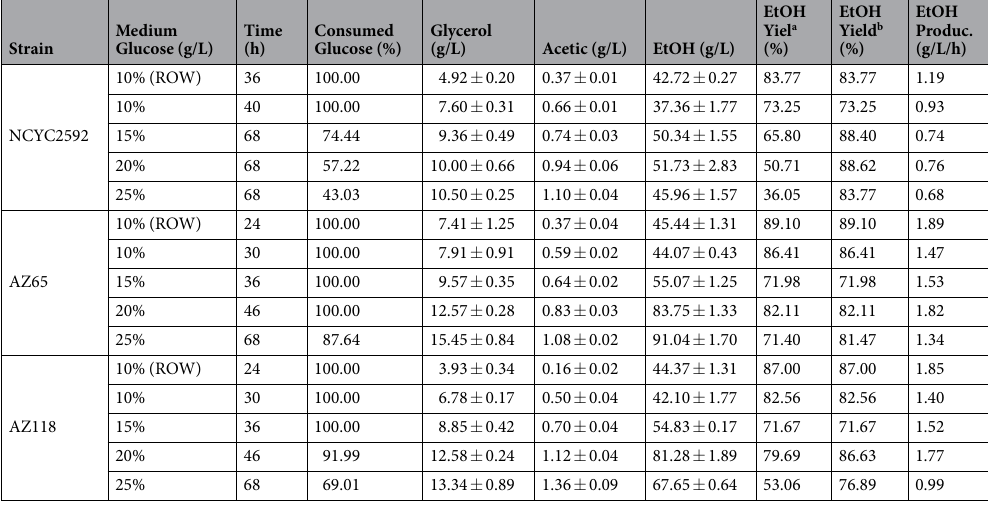
Table 3. HPLC analysis for fermentations using SW-YPD media containing increased glucose concentrations (10–25%). a Calculated as a percentage of the theoretical yield (0.51) based on the total glucose used in the fermentation medium. b Calculated as a percentage of the theoretical yield (0.51) based on the amount of utilised glucose by the end of the